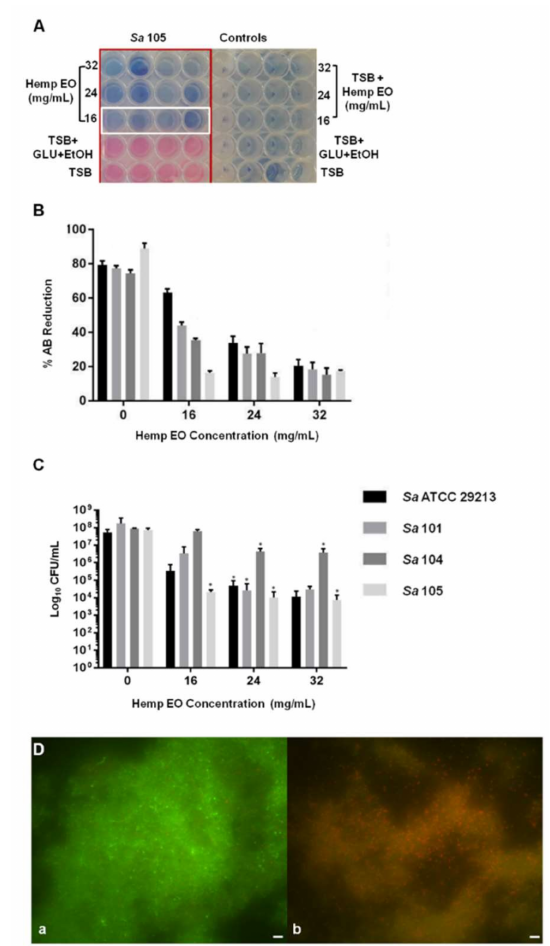
Figure 3. The evaluation of minimum biofilm eradication concentration (MBEC) of the hemp EO versus Staphylococcus aureus biofilm determined using the AB assay, live/dead staining, and fluorescent microscopy analysis and colony-forming unit (CFU) counts. ( A ) Representative image of colorimetric MBEC determination using AB. The white rectangles indicate the MBECs at 24 mg/mL S. aureus 105. ( B ) The plot shows the percent reduction of AB in the S. aureus broth cultures at different hemp EO concentrations compared to the corresponding untreated samples (0) evaluated as indicated in Section 2. ( C ) CFU count of treated and untreated S. aureus biofilms. ( D ) Representative image of S. aureus ( a ) untreated and ( b ) treated biofilms with 24 mg/mL hemp EO. The biofilms were stained with a live/dead kit and visualized using fluorescent microscopy. The green fluorescence indicates live cells, whereas the red fluorescence indicates dead cells or cells with a compromised cell wall. TSB: tryptic soy broth; GLU: glucose. Data are presented as the mean of three replicates of three independent experiments; * p < 0.05 vs. the controls